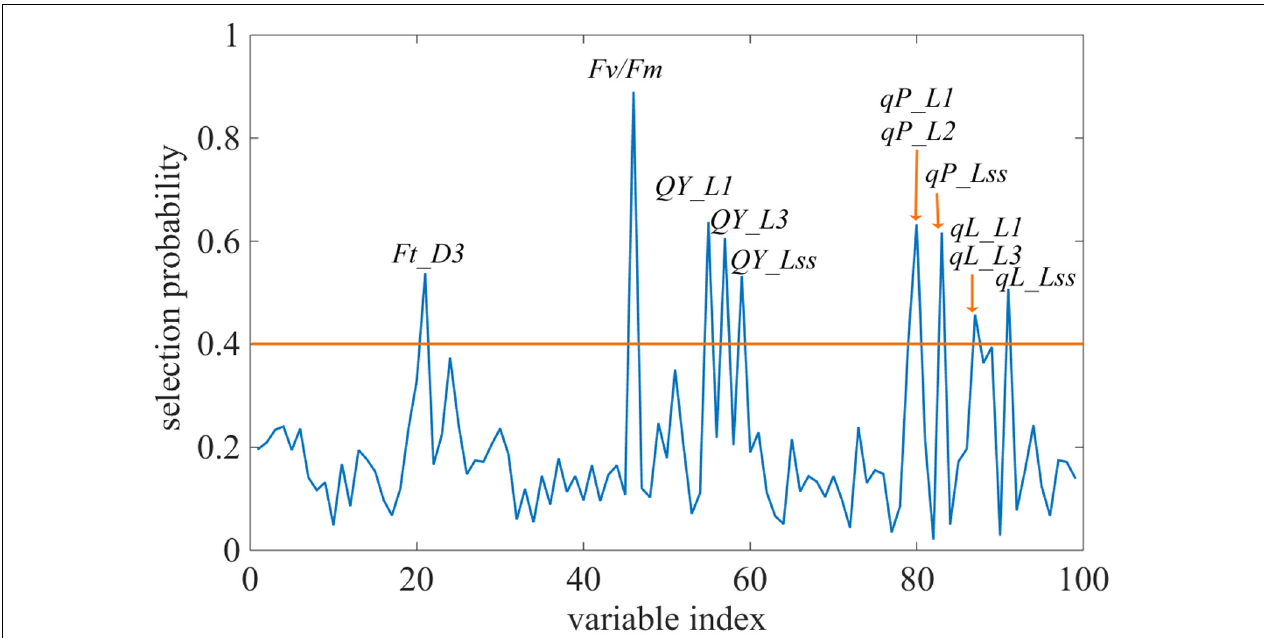
FIGURE 8 | Selection probability of each feature by the Random Frog algorithm. The orange line highlights the selection probability threshold of 0.4.